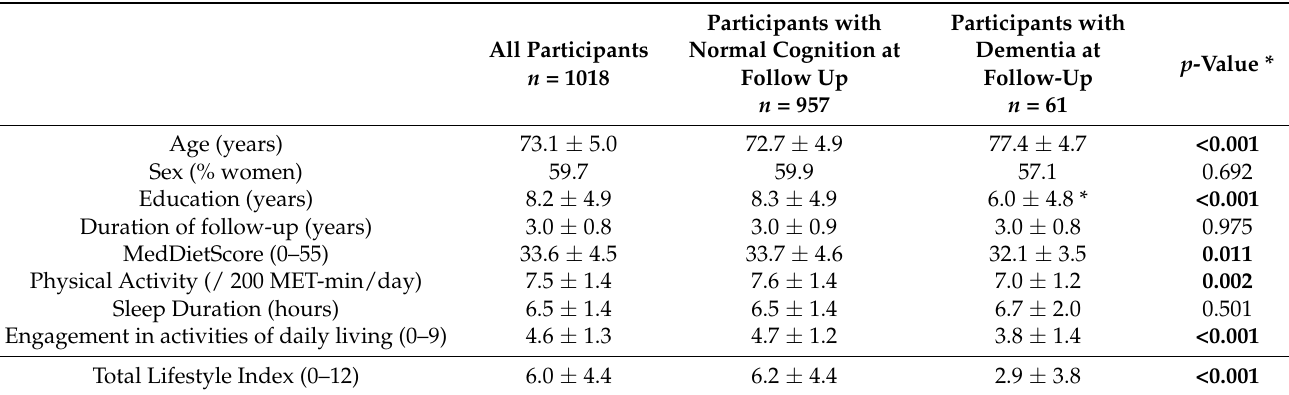
Table 1. Baseline demographic and lifestyle characteristics of the participants and by diagnosis at follow-up. Participants with Normal Cognition at All Participants n = 1018 Follow Up n = 957